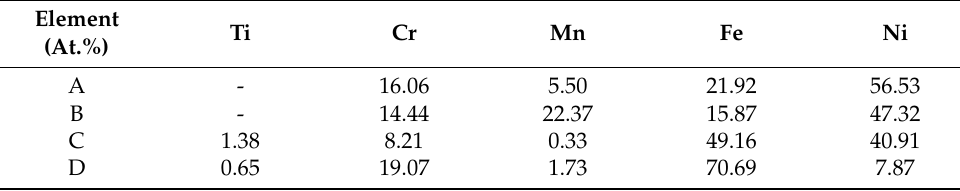
Figure 9. The SEM image and the corresponding element map distribution of brazing alloy on sub- strates of acid treatment + 10 μm Ni at 1170 °C/25 min. Table 5. The EDS results in Figure 9. Element (At.%)